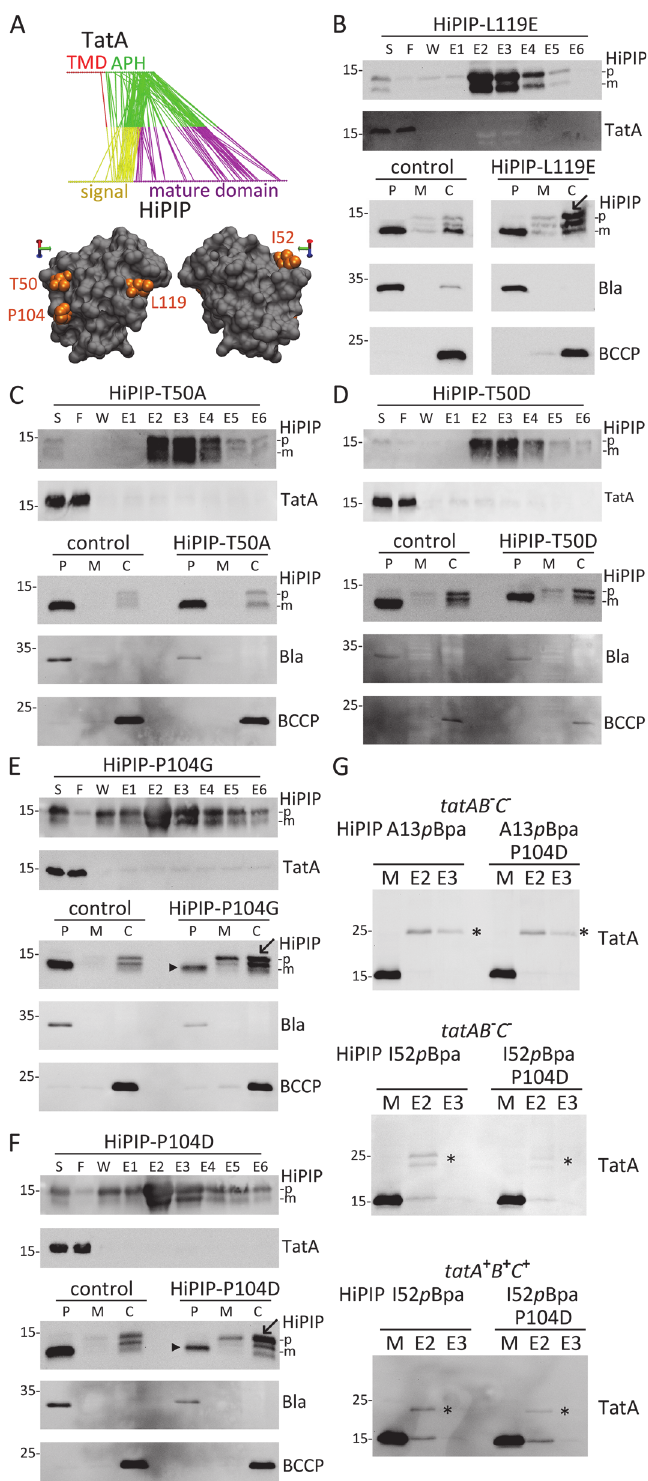
Fig 8. Identification of TatA-binding determinants on the surface of folded HiPIP. (A) Most frequent interactions observed in 50 independent molecular dynamics (MD) simulations of TatA-HiPIP interactions (upper diagram). Color code: yellow: HiPIP signal peptide; magenta: HiPIP mature domain; red: TatA trans- membrane domain; green: TatA amphipathic helix. The three residues on the HiPIP surface with